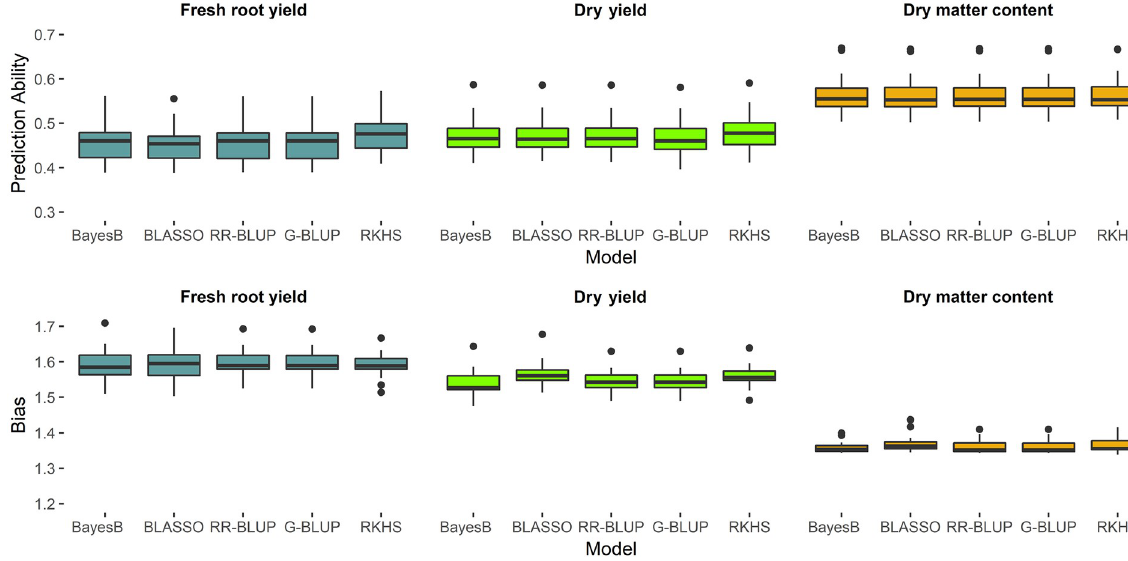
Fig 2. Predictive ability and bias boxplot for different genomic selection methods (BayesB, BLASSO, RR-BLUP, G-BLUP and RKHS) with the 1 st cross validation strategy, for fresh root yield, dry root yield and dry matter